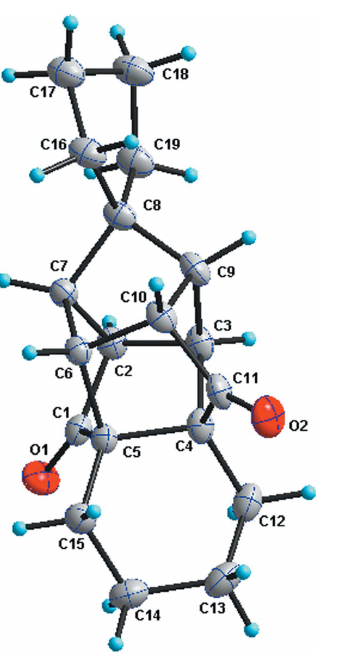
Figure 1 The molecular structure of the title compound II with displacement ellipsoids drawn at the 50% probability level.